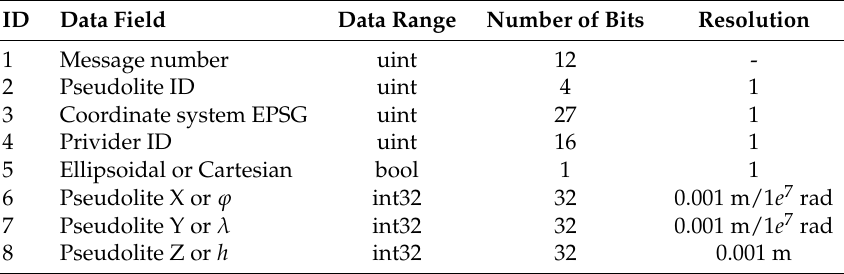
Table 4. Pseudolite specific part of proposed RTCM